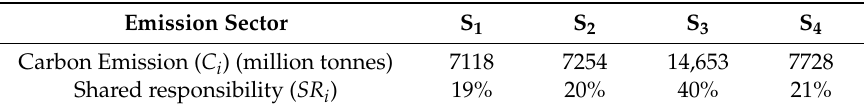
Table 5. Shared responsibility between four emission